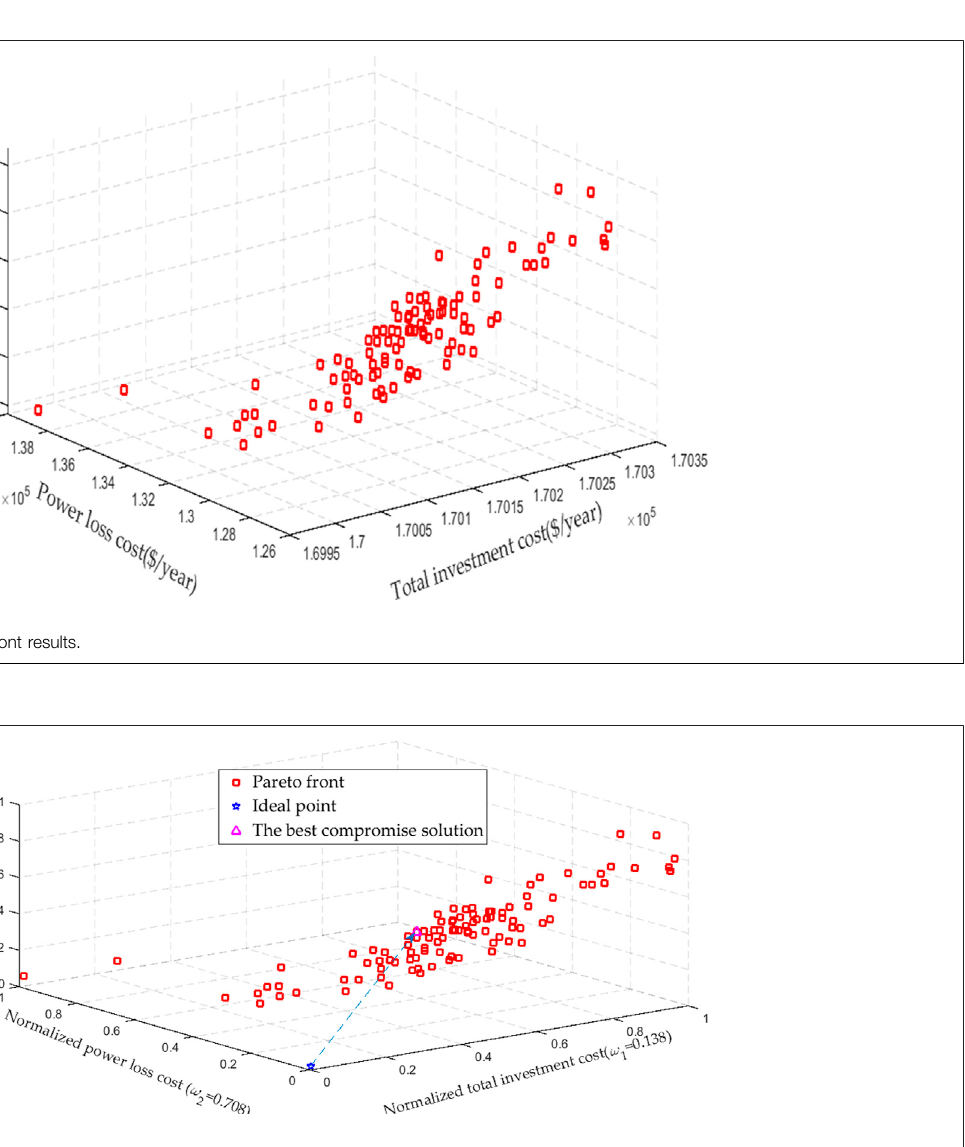
FIGURE 5 | Schematic diagram of IPDM based on